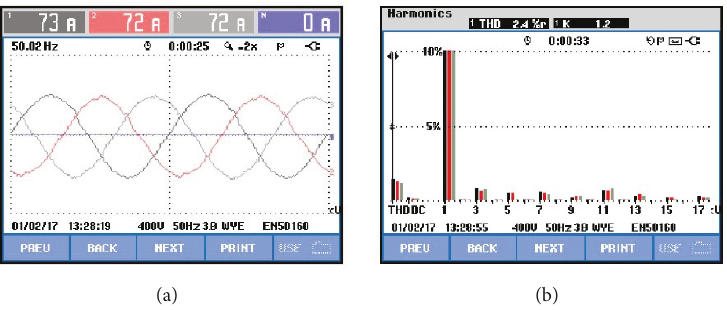
Figure 19: The experimental waveforms and THD of grid currents using the proposed method ( 𝑘